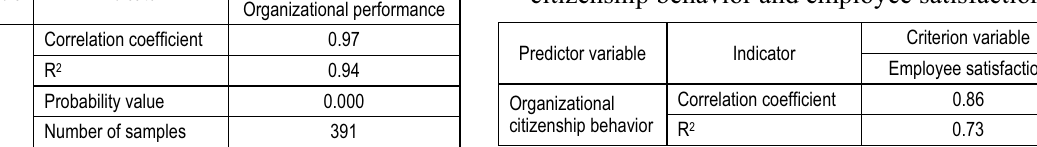
Table 5. The relationship between